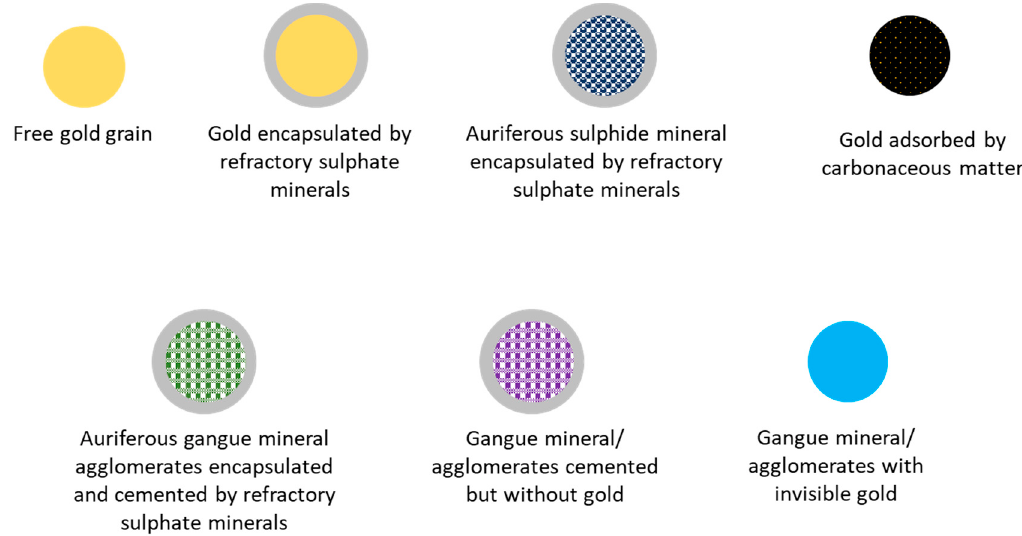
Figure 4. Illustration of the occurrence of gold in the investigated flotation concentrates and bio-oxidation products.